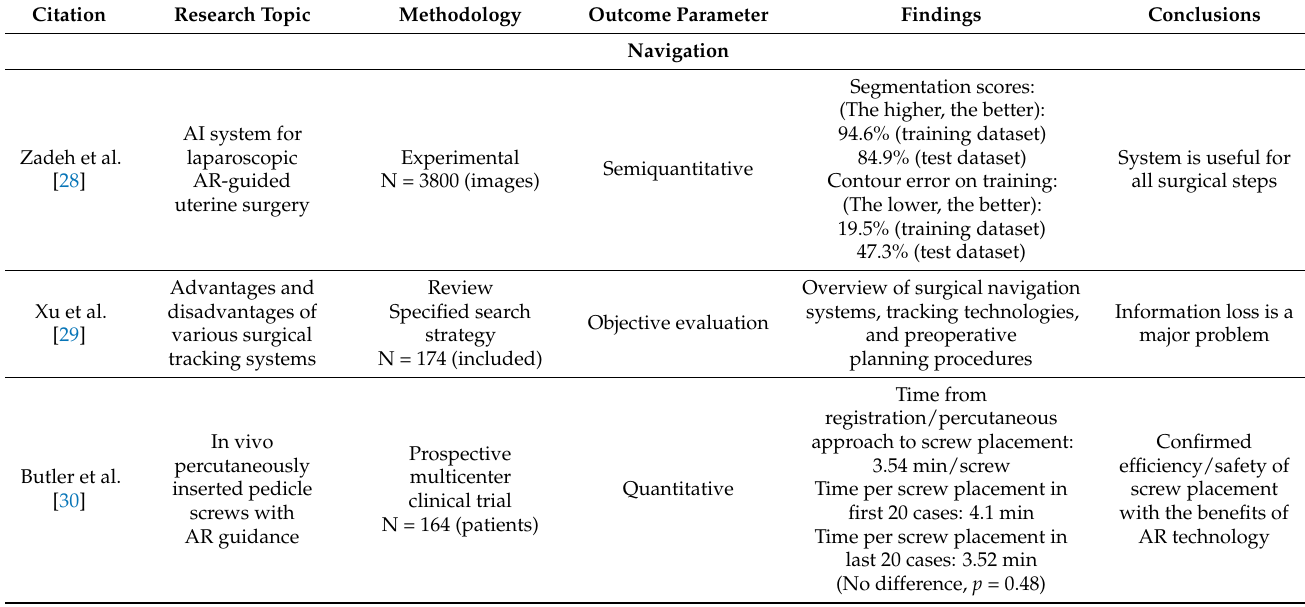
Table 1. Categorization of scoping literature search results in relation to the different MIS practice